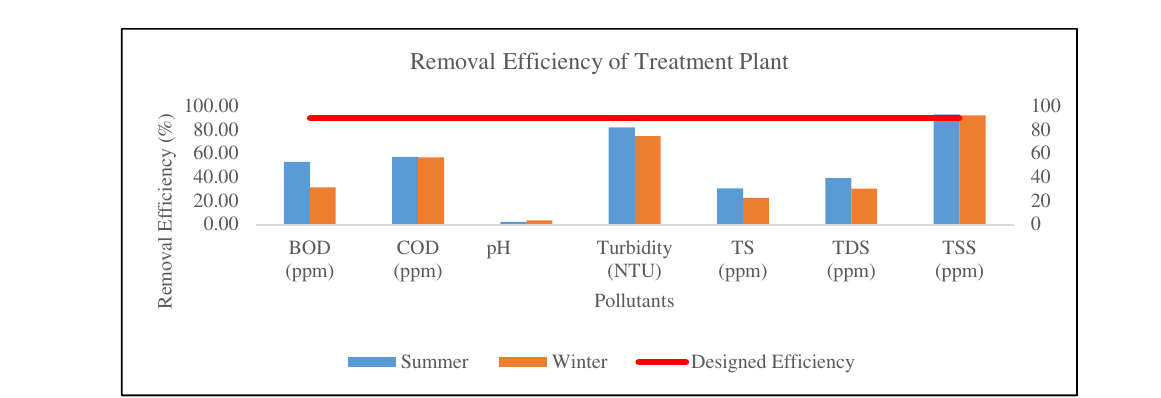
Fig. 4: Removal Efficiency of Treatment Plant in Removing Selected